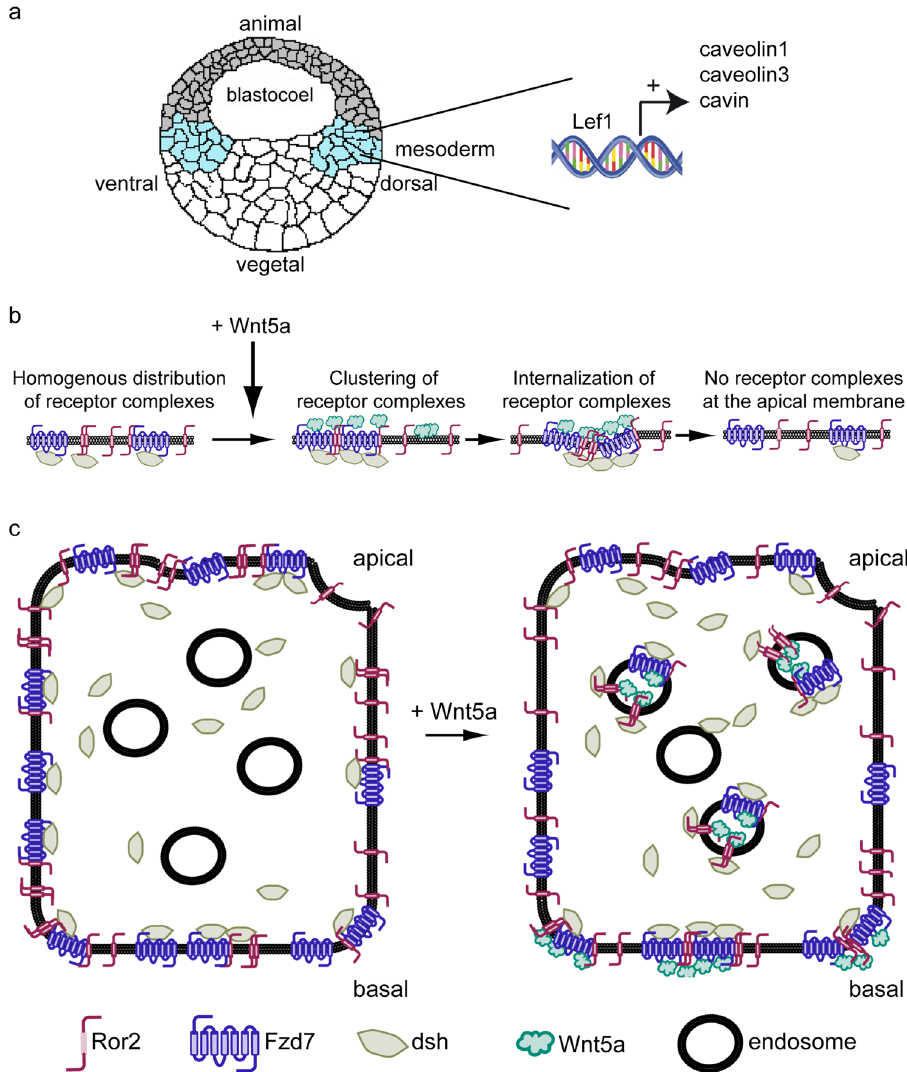
Figure 7. The Lef1 targets of the caveolin family are required for Wnt5a induced receptor complex internalization. ( a ) Lef1 regulates the expression of the caveolar core components caveolin1, caveolin3 and cavin1. ( b ) Wnt5a induces rapid clustering of non-canonical receptor complexes and subsequently their internalization via clathrin and caveolin dependend mechanisms, ( c ) Apical internalization of receptor clusters results in a symmetry break of polarized cells with membrane bound receptor clusters at the basal